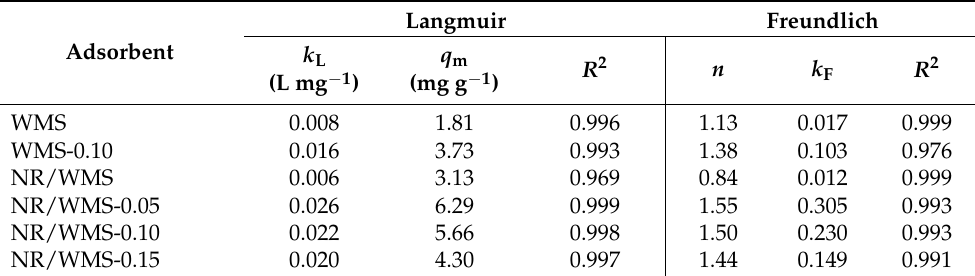
Table 4. Isotherm parameters of CFA adsorption onto the